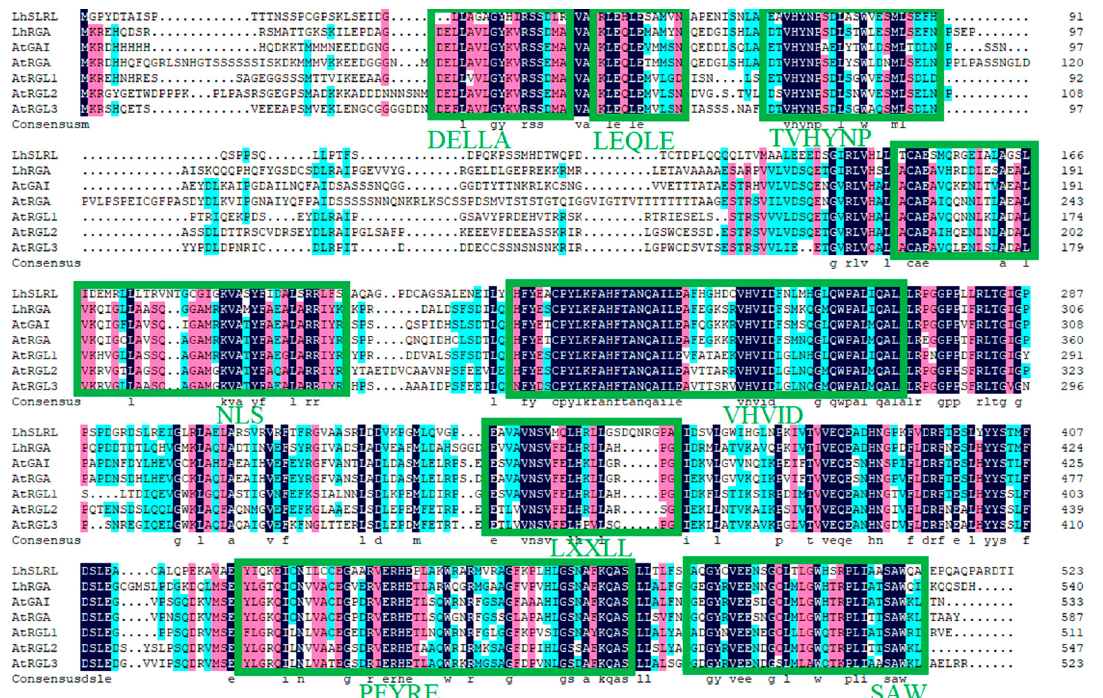
Figure 2. Sequence alignments of LhDELLAs to AtDELLAs. Amino acid sequences were aligned using DNAMAN 8. The conserved domains of the DELLA protein are framed by green lines. Identical and similar amino acid residues were shaded with black, pink, and blue, respectively.